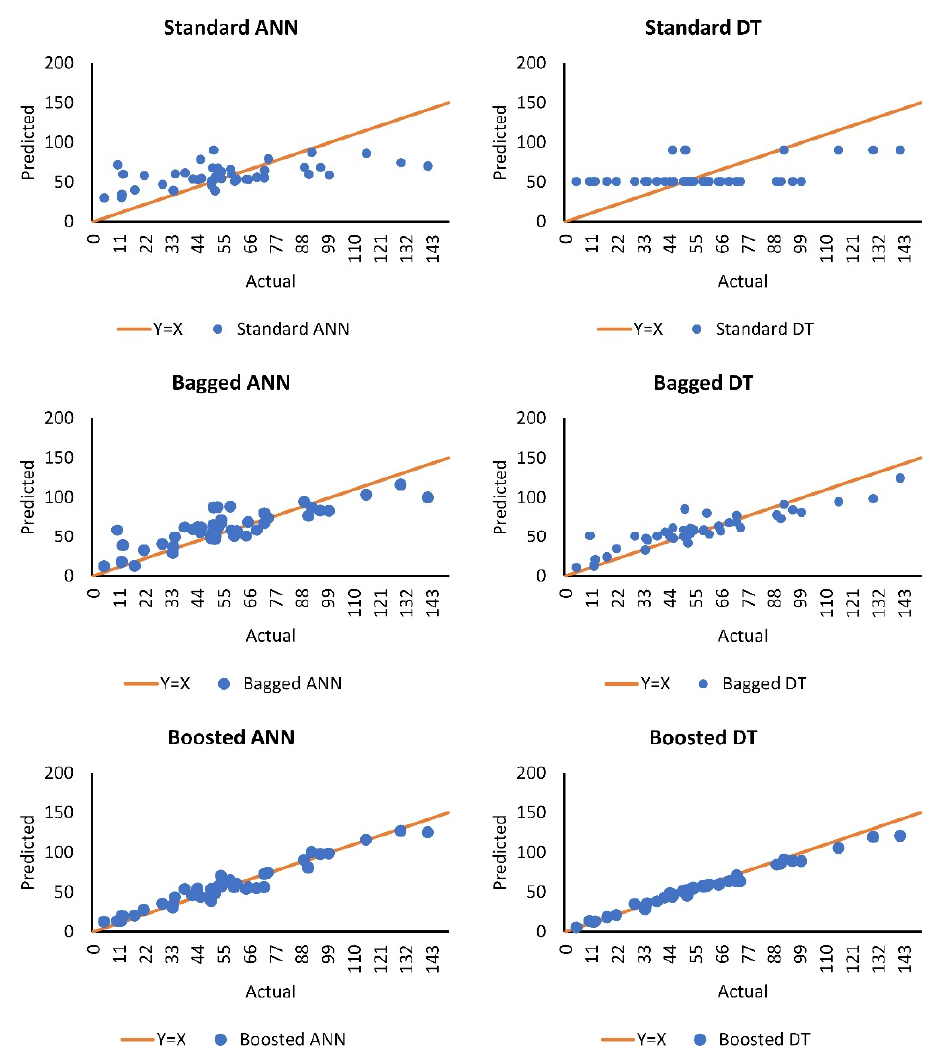
Figure 7. Actual and predicted values of the models developed in this study. Table 5. Details of models’ Table 4. Models’ performance.